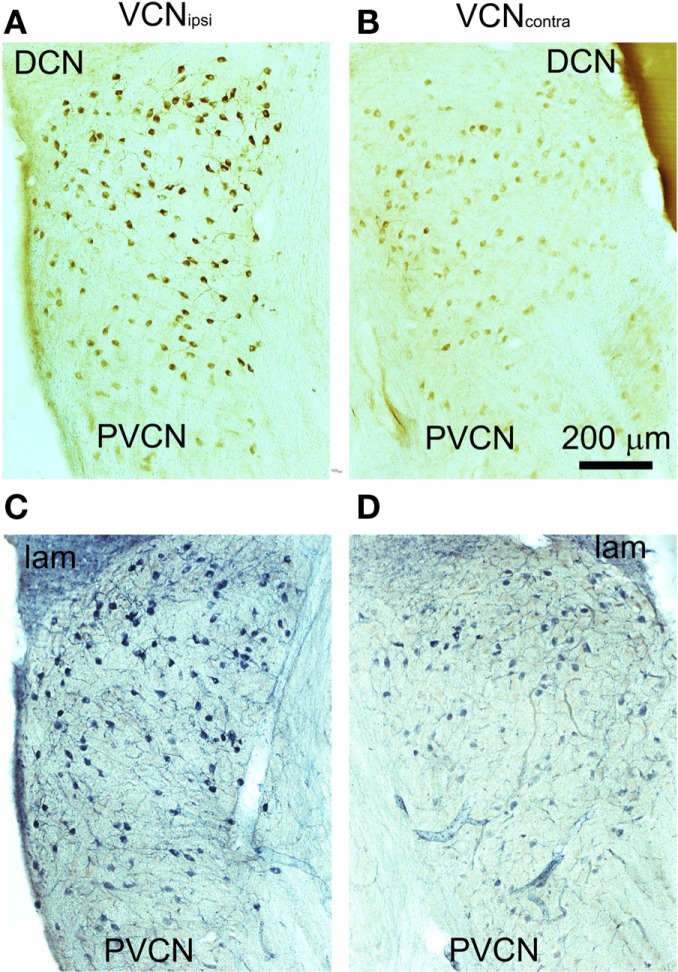
Representative coronal sections through PVCN from an animal with behavioral evidence of tinnitus. Sections were stained immunohistochemically for nNOS (A,B) or for NADPH-diaphorase (C,D). Unilateral AOE leads to more densely stained neurons in the VCNipsi
(A,C) compared with the VCNcontra
(B,D).